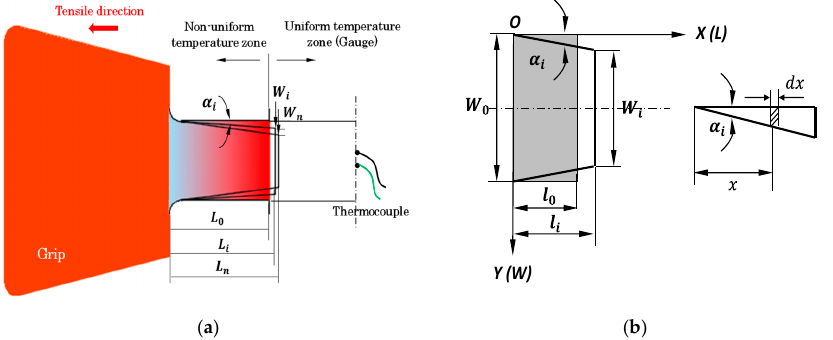
Figure 4. Geometrical model of Gleeble tensile test: ( a ) Geometrical model; ( b ) Non-uniform angle variation model.